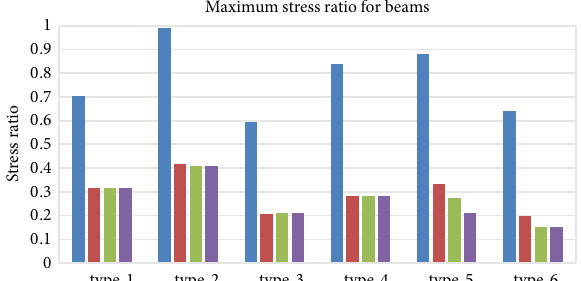
Fig. 18. The stress ratio of columns for the third model